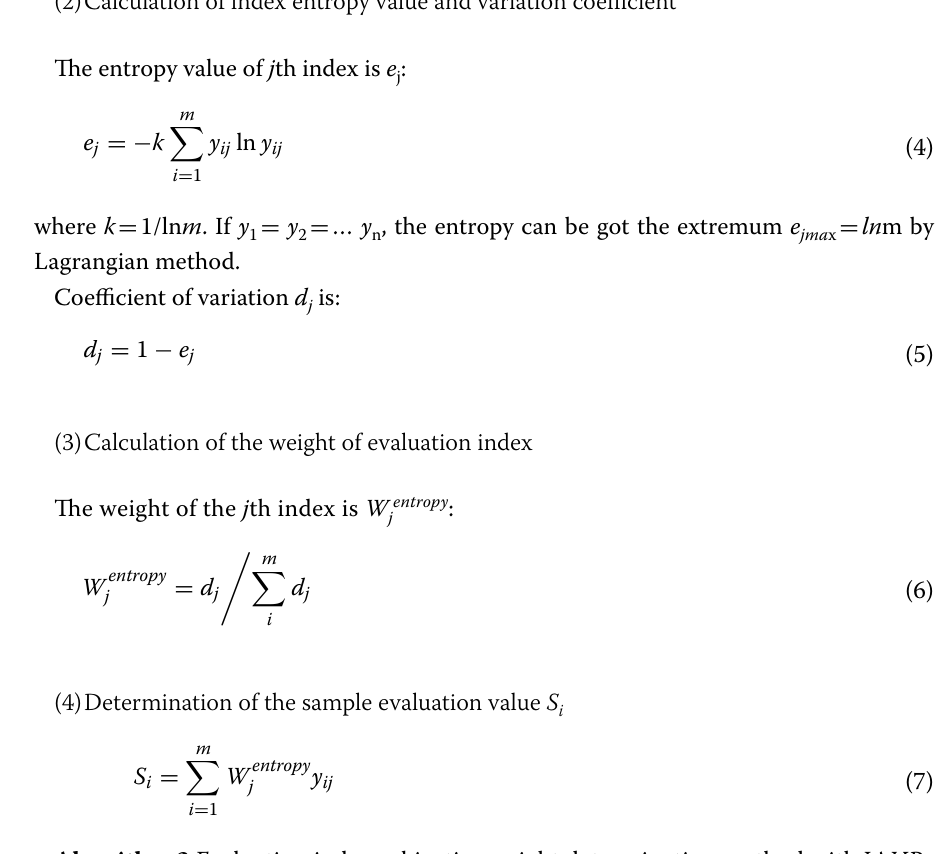
Algorithm 2 Evaluation index subjective weight determination method with